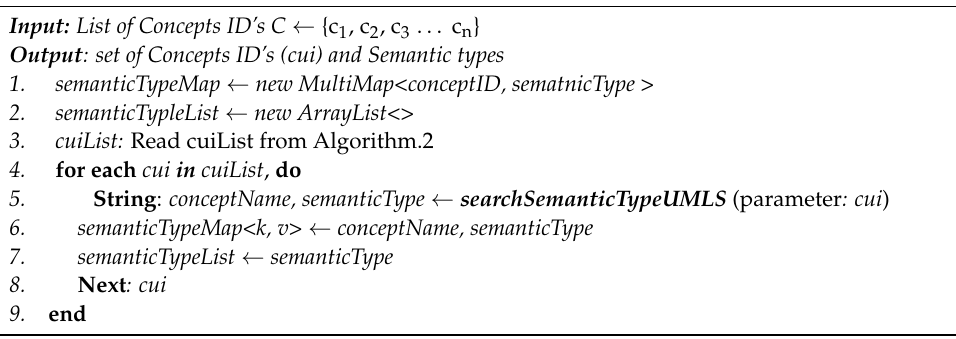
Algorithm 3 : Semantic-Type Identification from